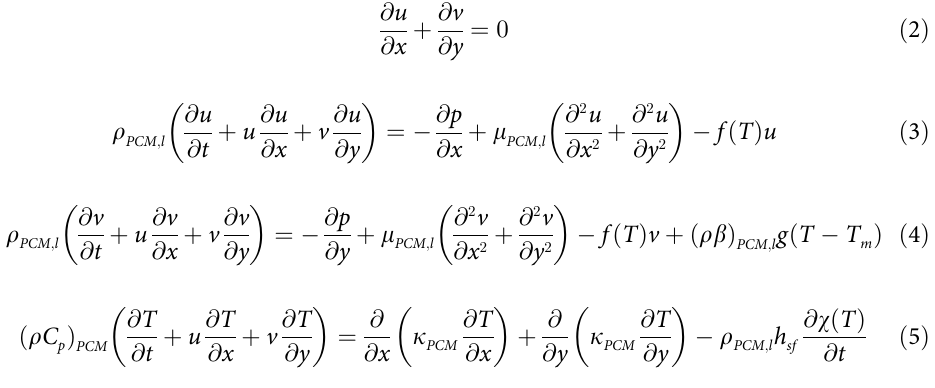
Table 1. Thermophysical properties of the Capric acid [54, 55]. Properties Capric acid Specific heat (kJ kg -1 K -1 ) Liquid: